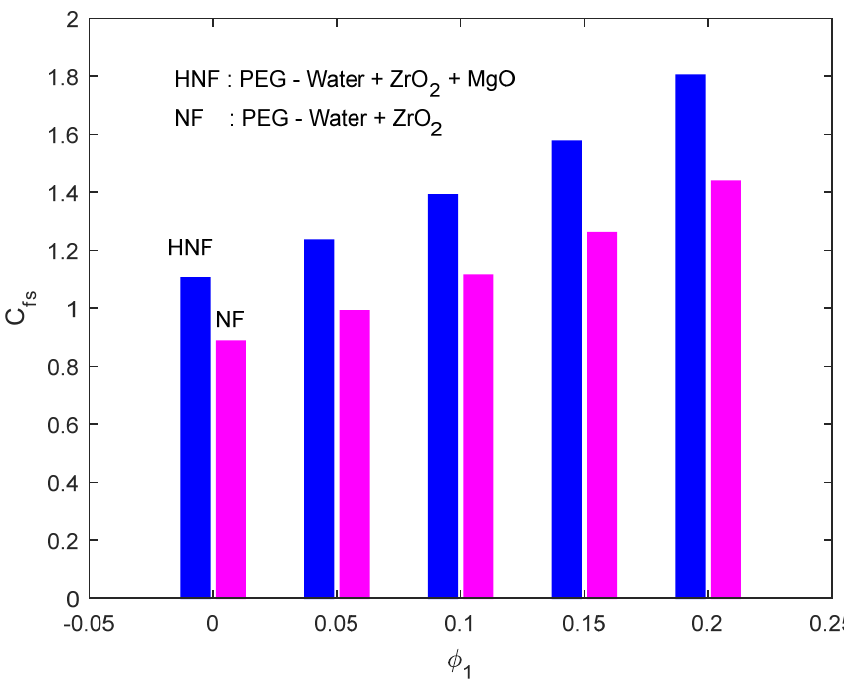
Figure 3. Effects on skin friction coefficient due to φ 1 .